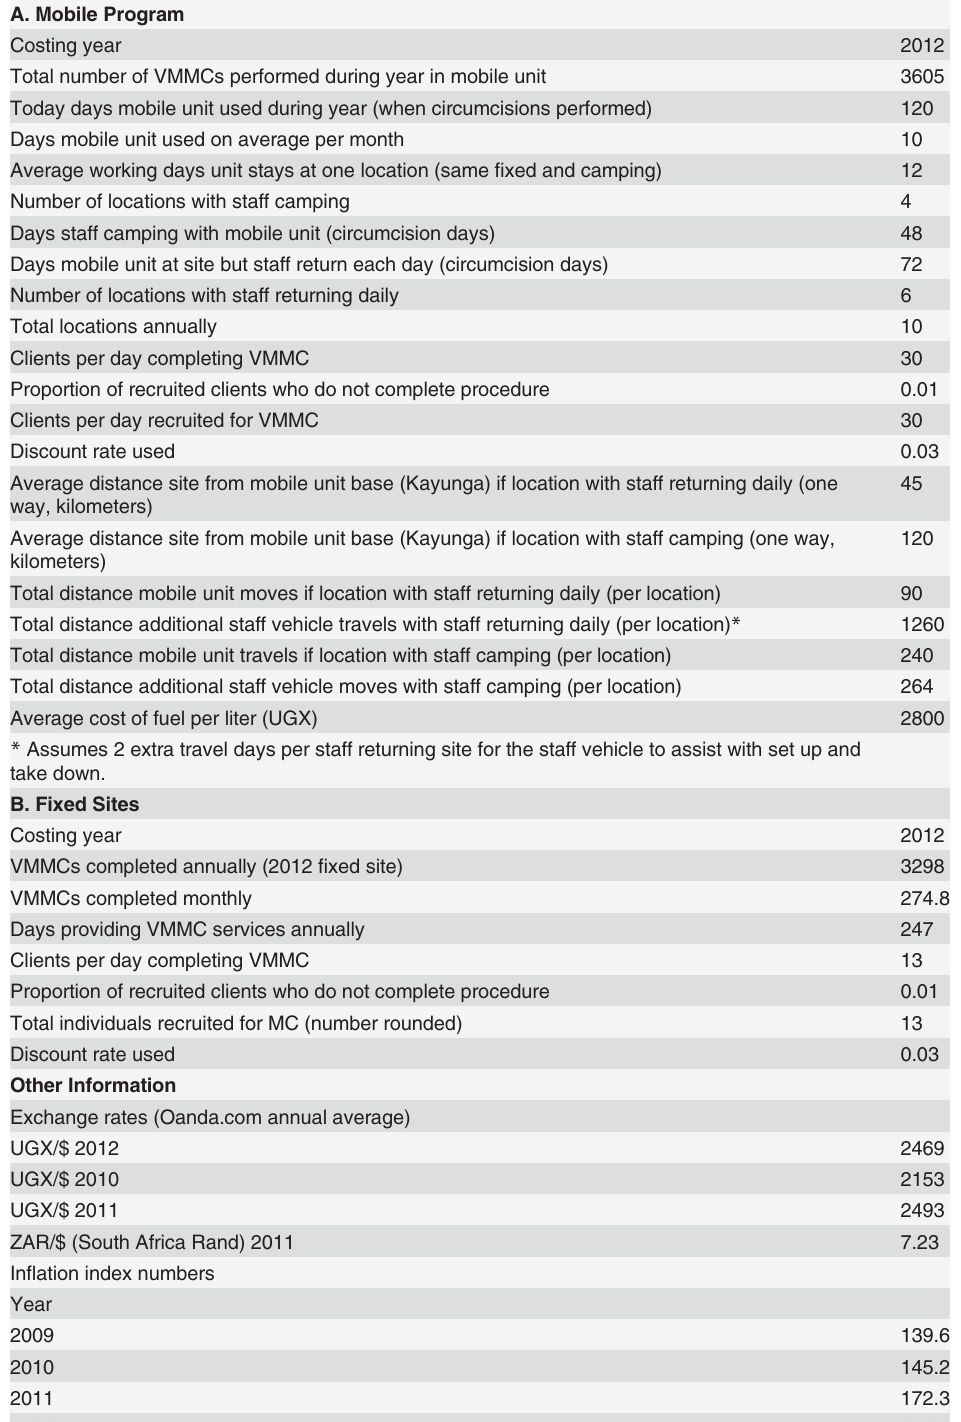
Table 1. Preliminary information for mobile program and fi xed